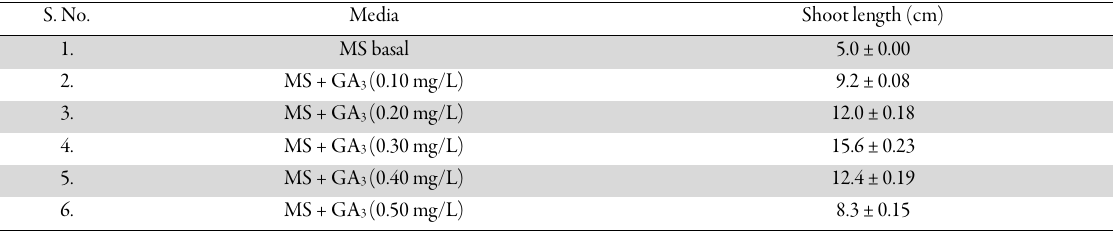
Table 2. Effect of plant growth regulator GA 3 on in vitro shoot elongation of Withania somnifera (L.) Dunal S. No.